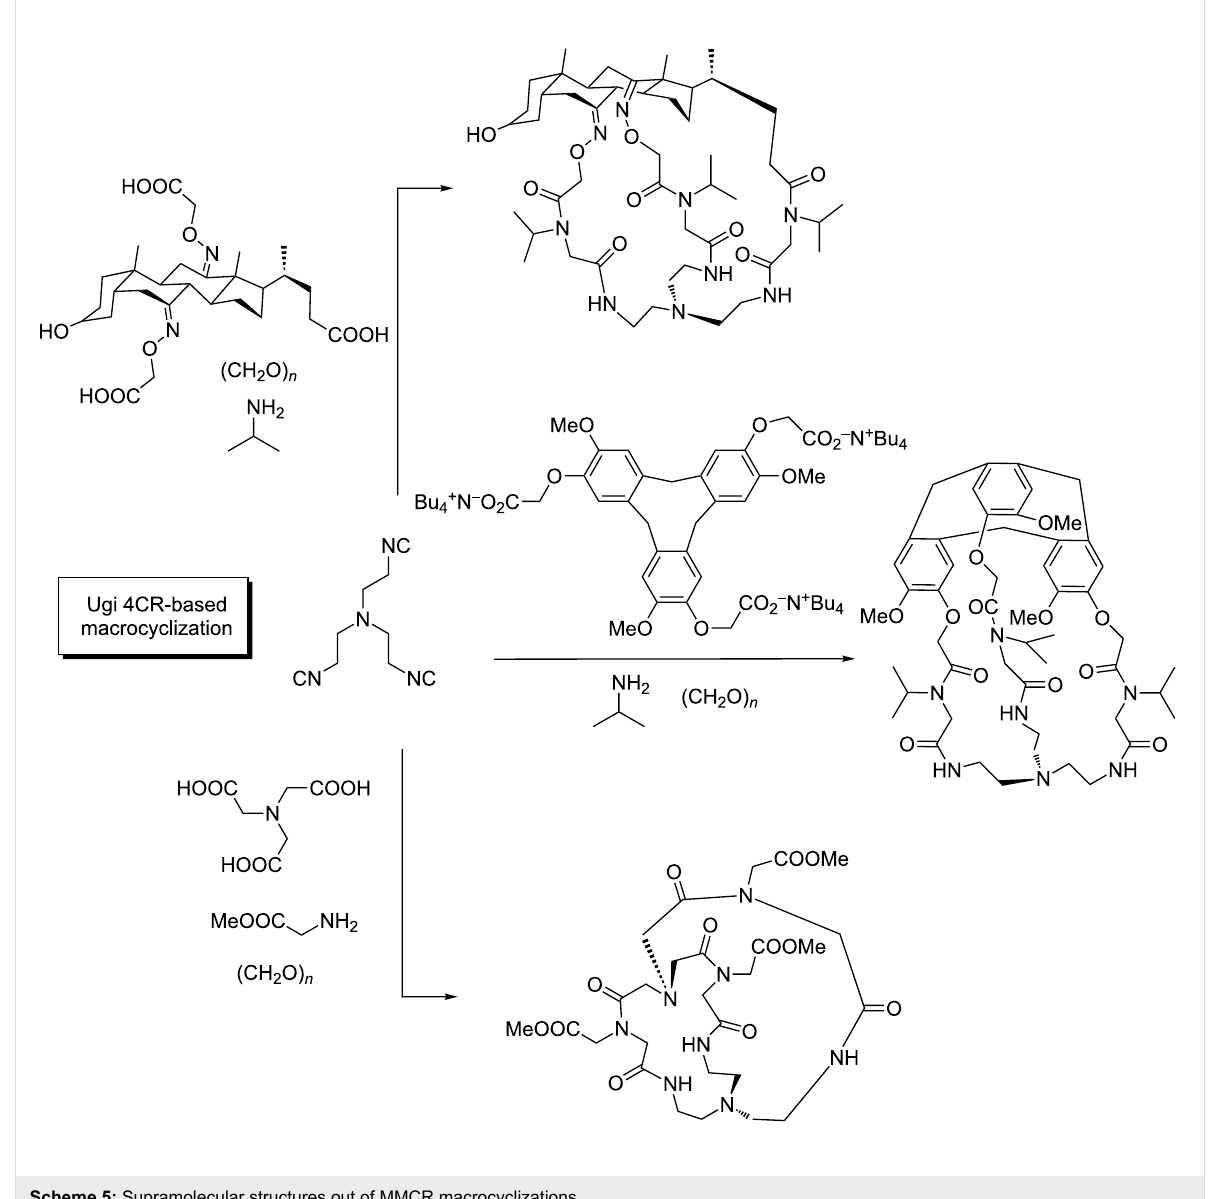
Scheme 5: Supramolecular structures out of MMCR